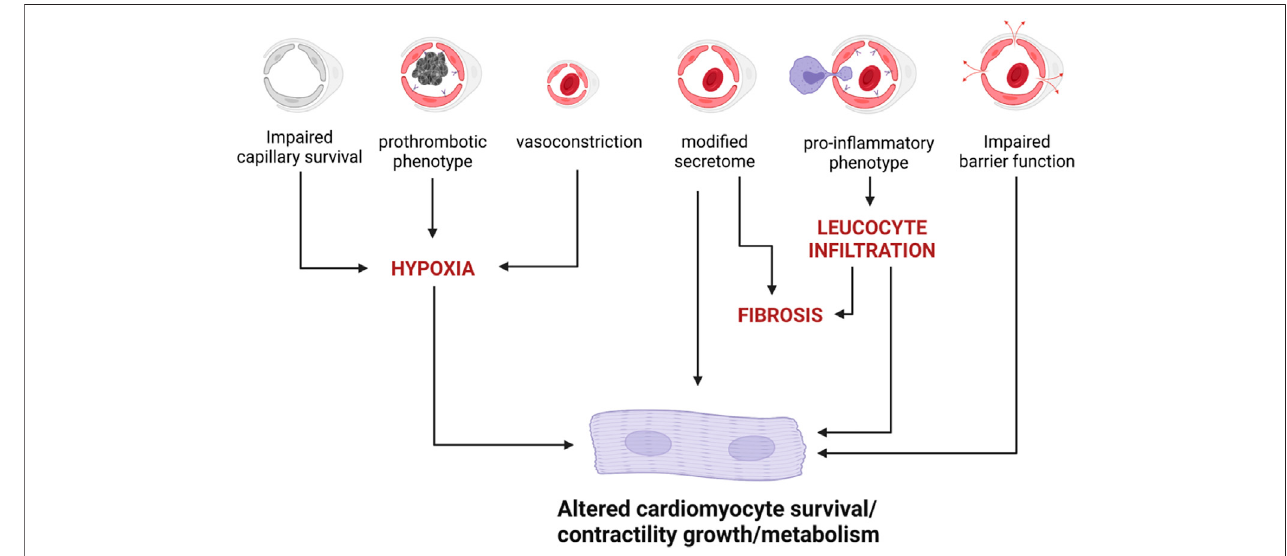
FIGURE 3 | EC dysfunction may induce cardiomyocyte impairment via several